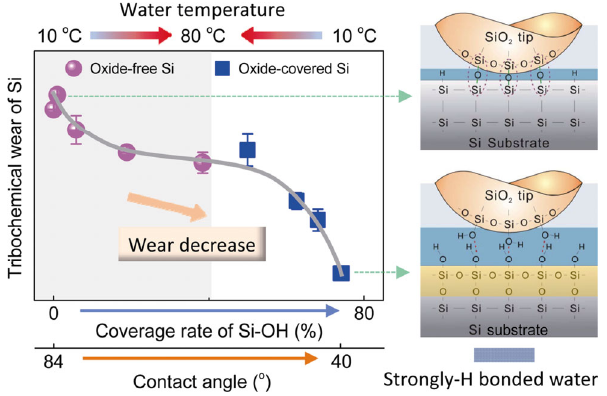
Fig. 17 Correlation between tribochemical wear and coverage rate of hydroxyl groups (surface wettability) on oxide-free Si and oxide-covered Si surfaces as water temperature ranges from 10 to 80 °C. The solid line is drawn as guide. Right insets are schematics of mechanism of temperature-dependent tribochemical wear of silicon slide against SiO 2 micro-sphere in deionized (DI) water with thin strongly hydrogen-bonded water layer for hydrophobic substrate case (upper inset) and thick strongly hydrogen-bonded water layer for hydrophilic substrate case (bottom inset). Reproduced with permission from Ref. [174], © American Chemical Society